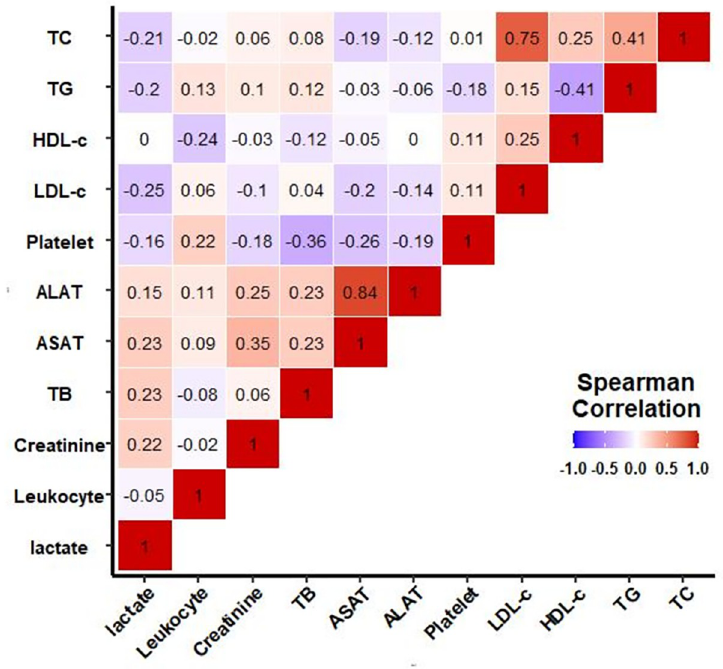
stasis. Kobashi et al. reported sepsis-associated liver dysfunction in 34.7% of the patients and distinguished 3 groups: “hepatocellular” (21.8%), “cholestatic” (48.1%) and “shock liver”